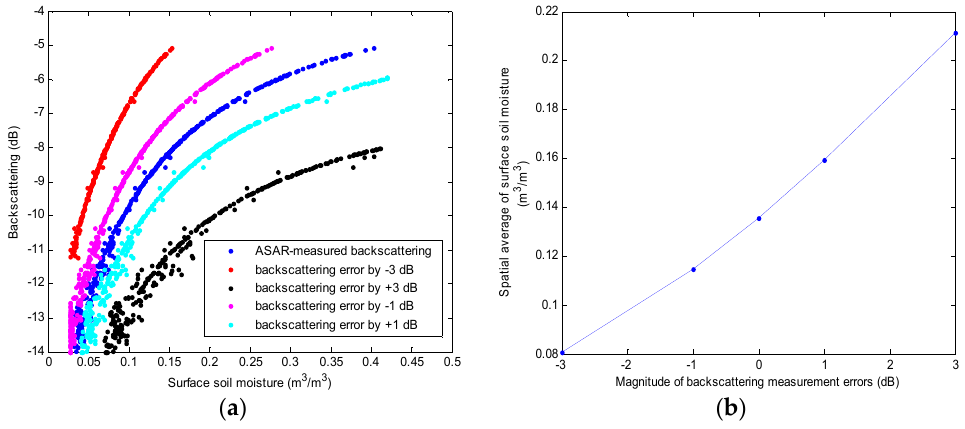
Figure 3. Backscattering experiments: ( a ) Relationship between ASAR backscattering with various hypothetical errors and resultant soil moisture retrievals; and ( b ) the spatial average of the surface soil moisture retrieved with different backscattering error magnitudes used by (a) on DoY 221.